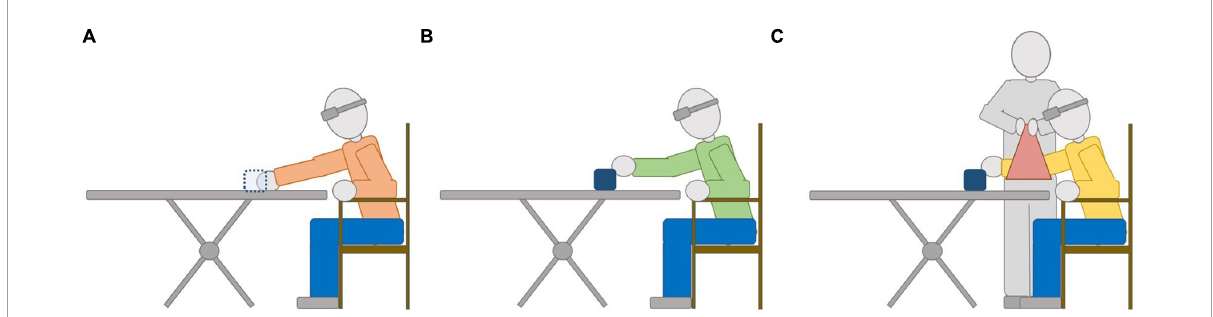
FIGURE1 Illustration of a reaching response on the Training phase for each Group: (A) CG, (B) AG, and (C) GC. The sound source is depicted in dotted (or continuous) lines depending on whether it is removed (or not) by the experimenter, respectively, after the end of the sound stimulus. See text for